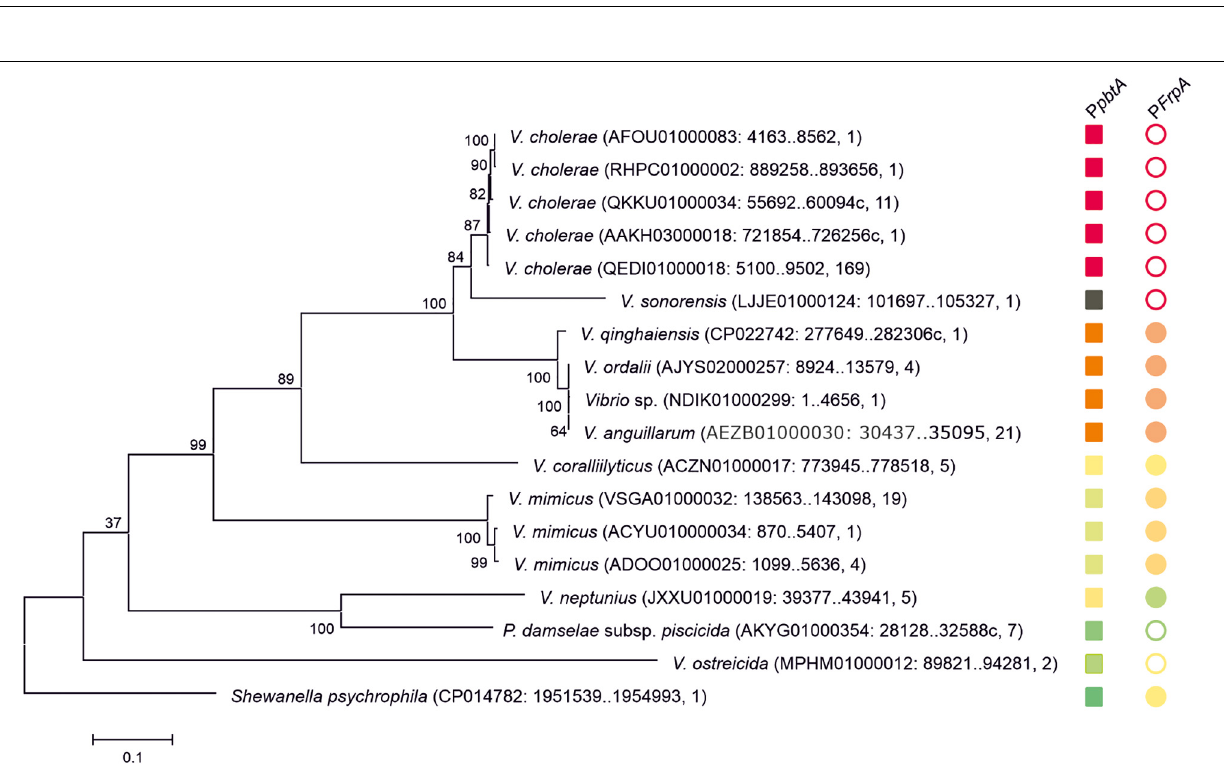
FIGURE 6 | Phylogenetic relationships of the pbtA-frpA region of irp -HPI genomic island and distribution of P pbtA and P frpA piscibactin promoter versions. Sequences are identified with species name. Sequence ID, sequence region, and the number of closely related sequences deposited in GenBank sharing coverage of 100% and identity nucleotide sequence ≥ 99.5% are shown between parentheses. The tree is drawn to scale, with branch lengths representing the evolutionary distances (number of base substitutions per site). The different versions of the piscibactin promoters P pbtA and P frpA are represented with squares and circles, respectively. Filled circles denote “long versions” of frpA promoter while empty circles denote “short versions.” Closely related promoter sequences, according to pairwise nucleotide p-distances ( Supplementary Figures 3 , 4 ) are represented with the same color. P frpA promoter of V. sonorensis is represented with a black square since it does not align with the other